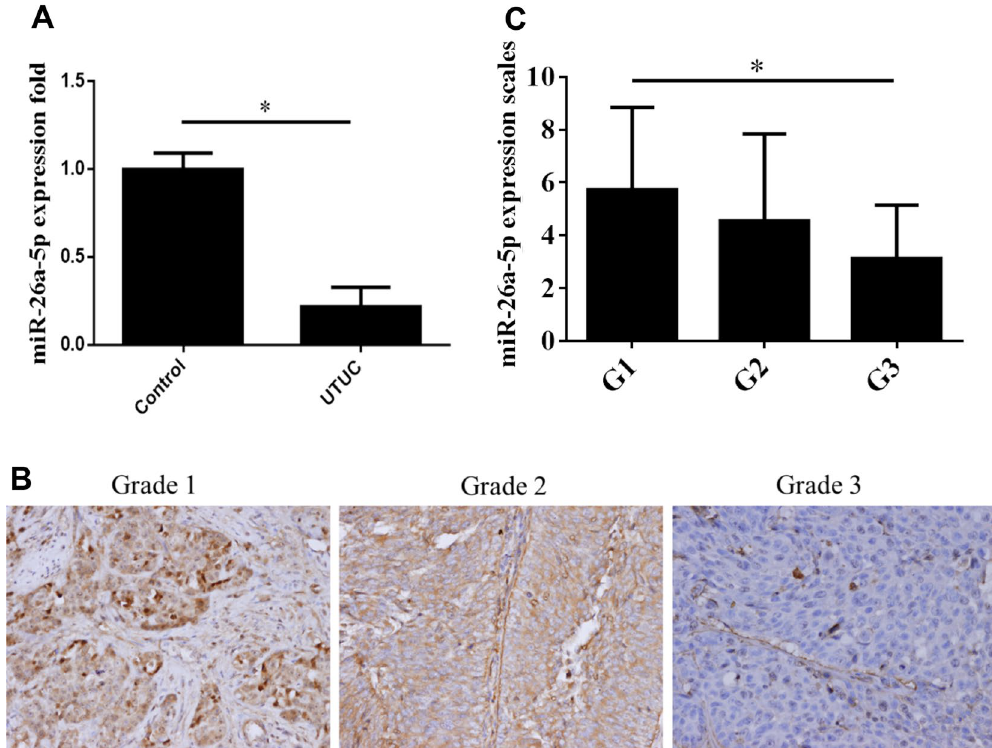
Figure 1. Expression profiles of miR-26a-5p in human UTUC samples. ( A ) Down-regulation of miR-26a-5p in UTUC tumor tissues (n = 22) compared with adjacent normal control (n = 14) by RT-qPCR analysis. ( B ) In situ hybridization (ISH) analysis of miR-26a-5p expression in TMA of human renal pelvis carcinoma, including Grade 1 (G1; n = 23), Grade 2 (G2; n = 33) and Grade 3 (G3; n = 8) samples. ( C ) Quantification of miR-26a-5p expression levels from ISH staining results. Data represent the mean ± SEM. * P < 0.05 compared between the indicated